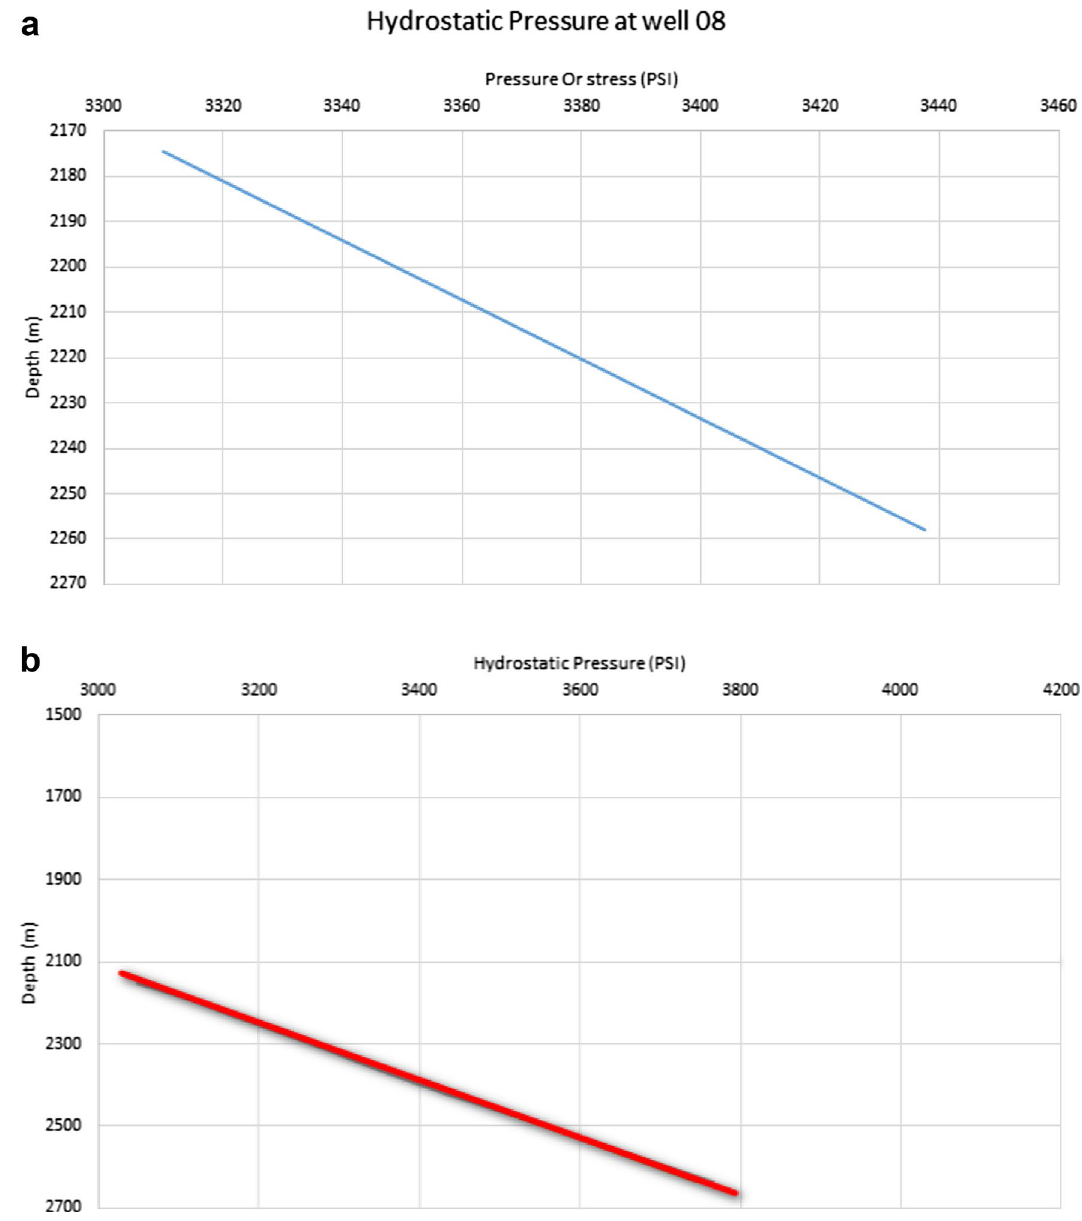
Fig. 2 Hydrostatic pressure at a well no. 8 and b well no.